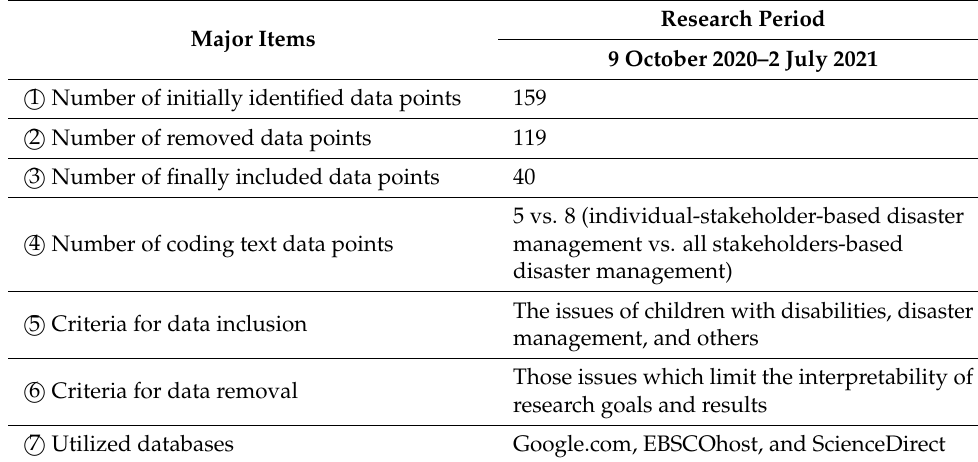
Table 2. Qualitative data information under the integrative review.